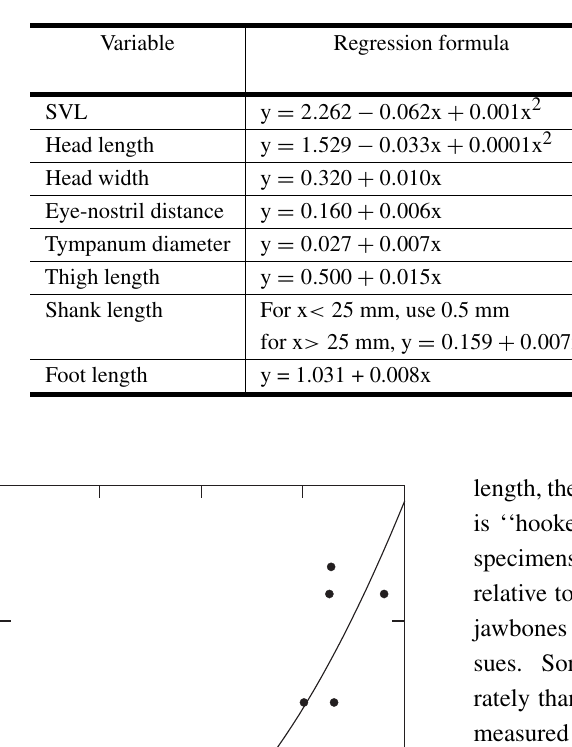
Regression formulae for measurement error of variables for leptodactylid frogs.